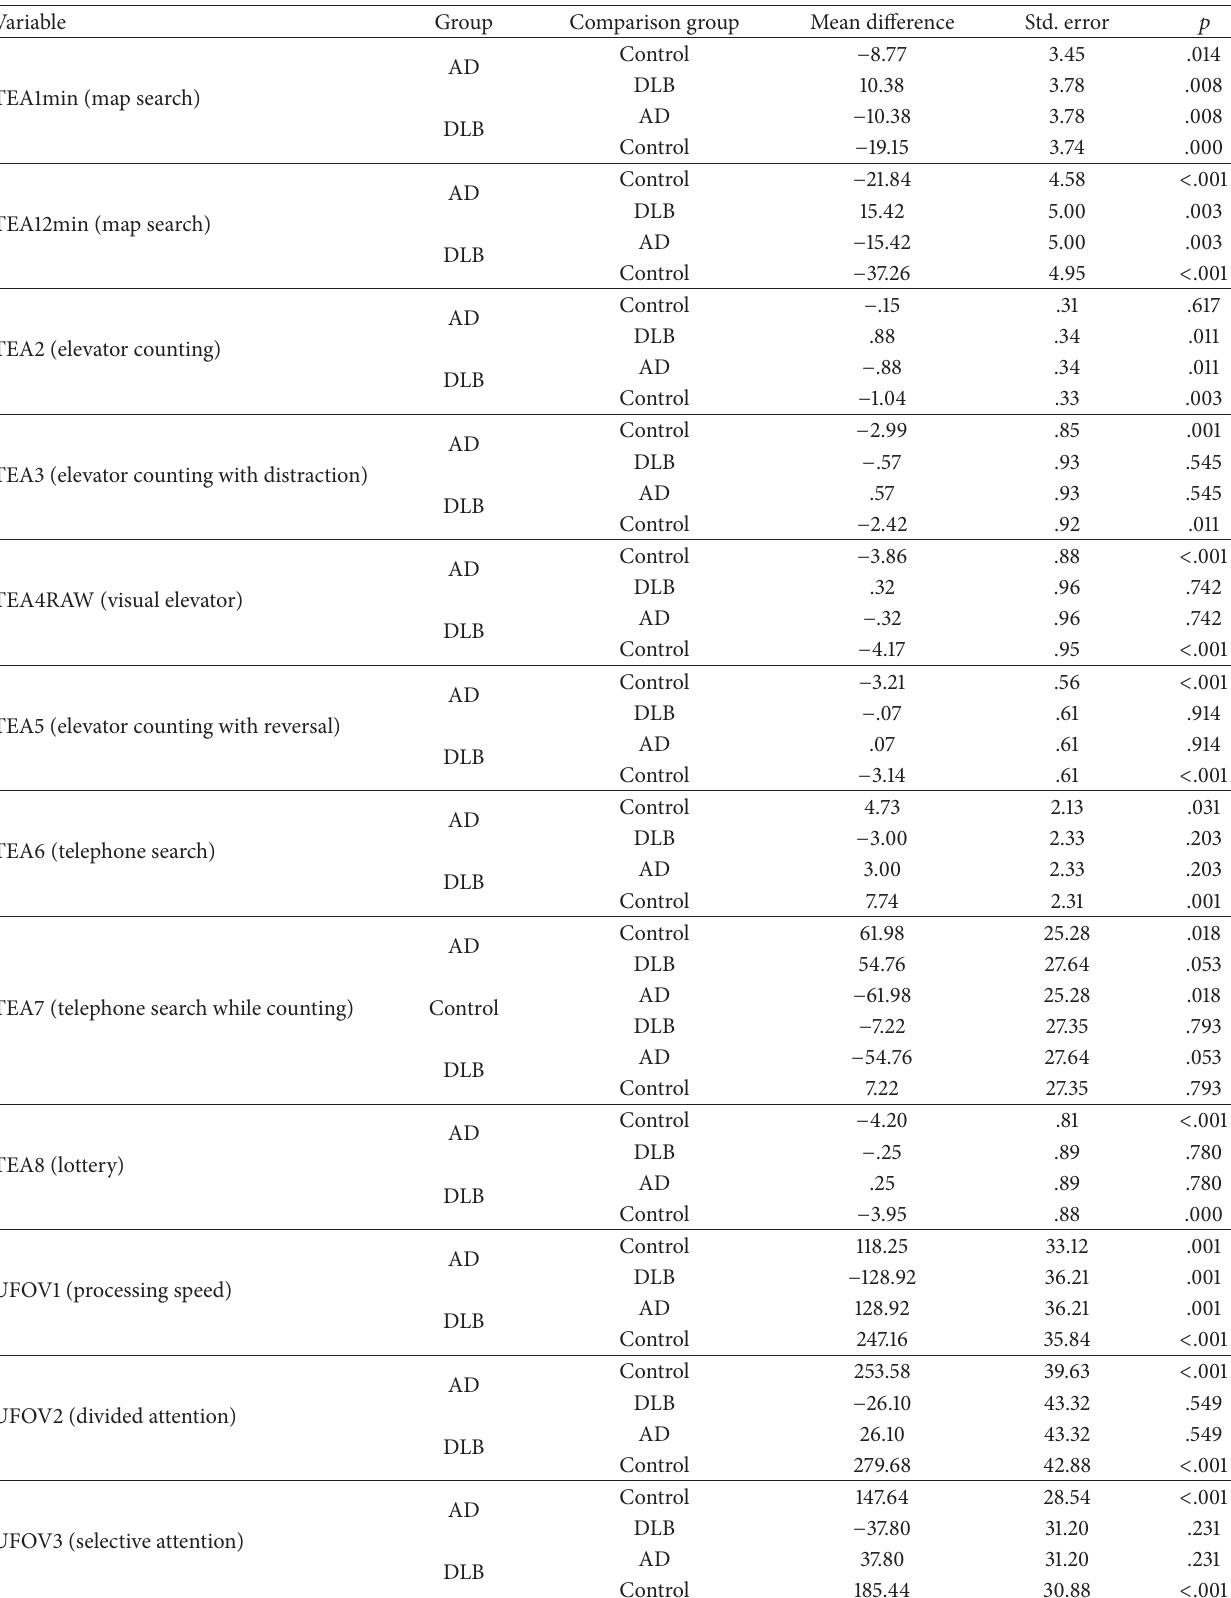
Table 3: Post hoc group comparisons (i.e., control, DLB, and AD) on measures of